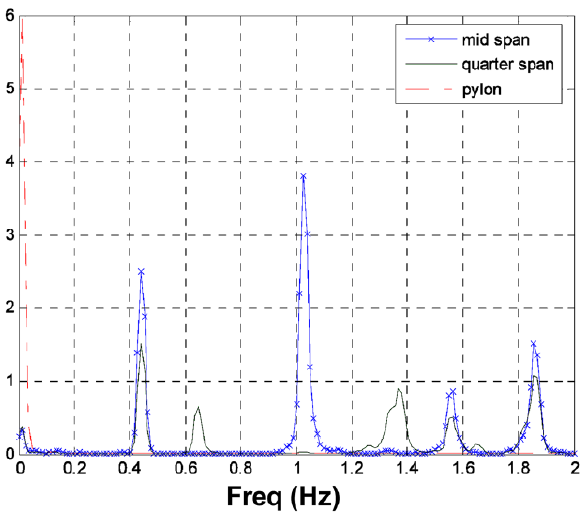
Figure 11. Power spectral density from the deck vibration at mid-span, quarter span, and pylon